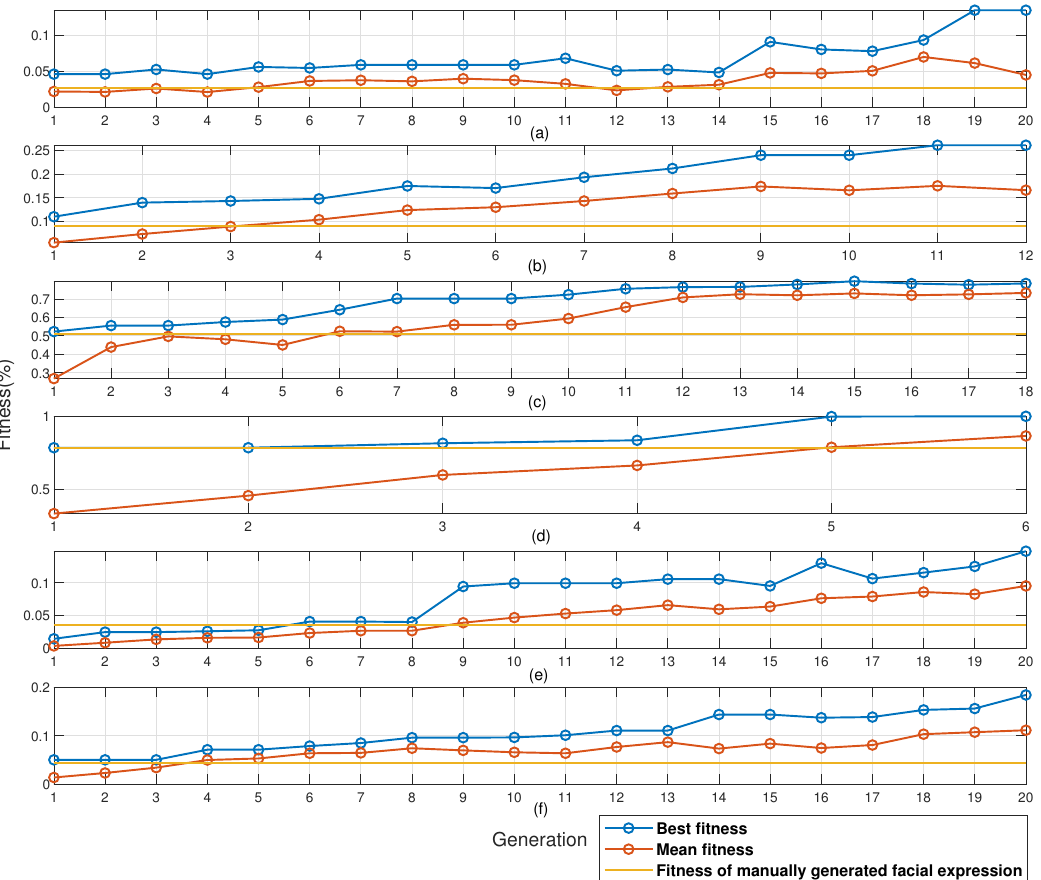
Figure 10. Comparison between fitness value of facial expressions generated by the proposed system and those generated manually in ’EveR’—( a ) Angry, ( b ) Disgust, ( c ) Fear, ( d ) Happy, ( e ) Sad and ( f )